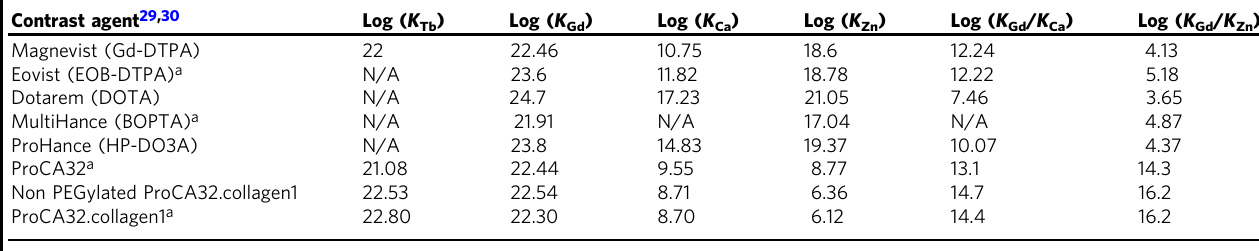
Table 2 Comparison of metal binding af fi nities (Gd 3 + , Tb 3 + , Zn 2 + , and Ca 2 + ) and selectivity of ProCA32.collagen1 with clinical contrast agents Contrast agent